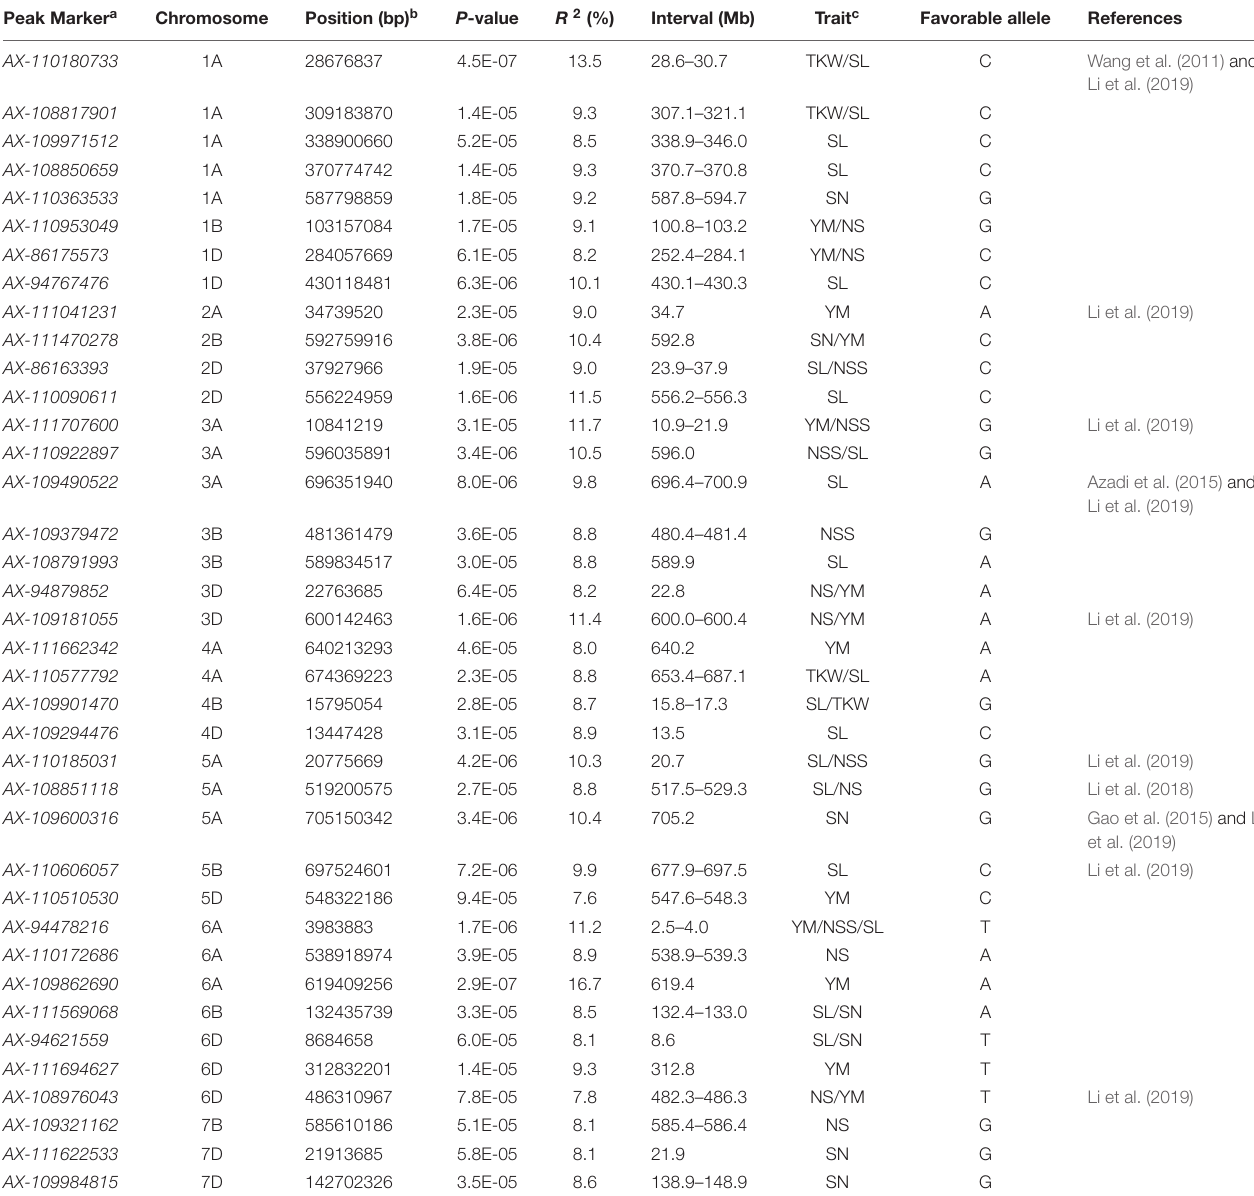
TABLE 2 | Loci for GY-related traits in 251 spring wheat accessions by association analysis. Peak Marker a Chromosome Position (bp) b P -value R 2 (%) Interval (Mb) Trait c Favorable